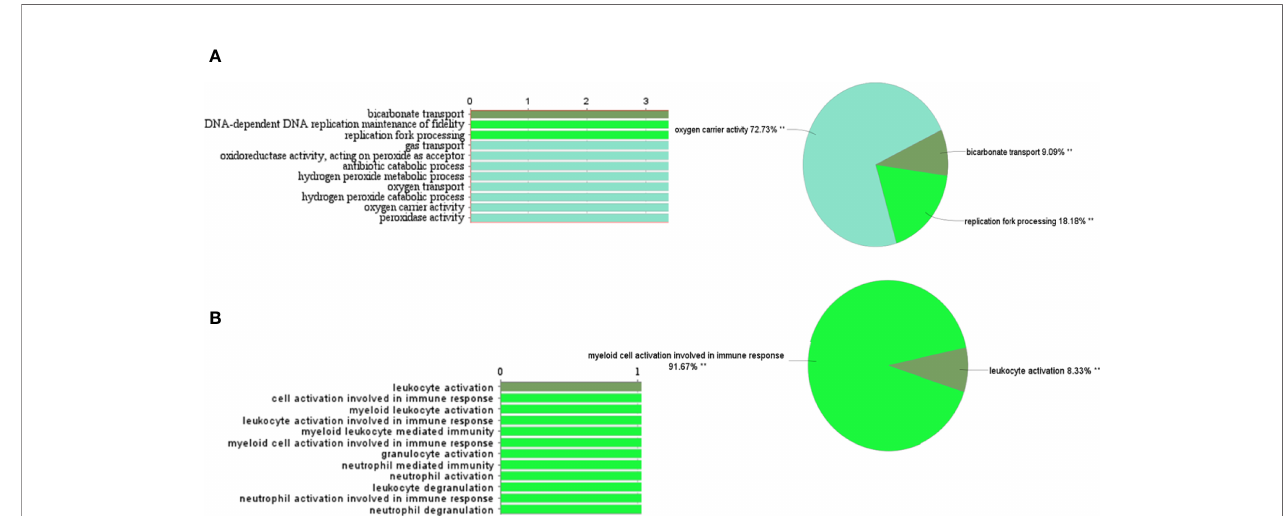
FIGURE 2 | Gene ontology and pathway analysis of DEGs and turquoise module genes through CluePedia. (A) The most important biological functions and pathways of the candidate DEGs. (B) GO and pathway related to turquoise